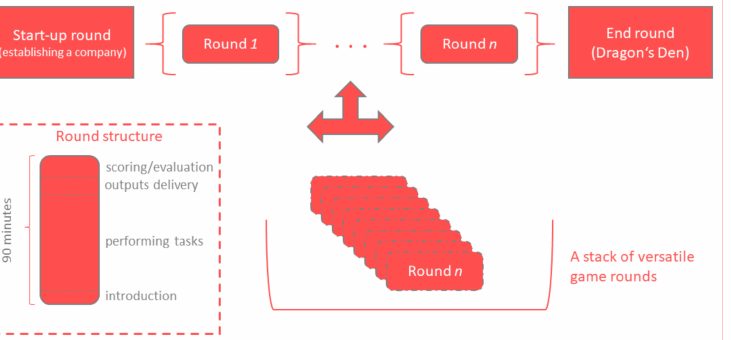
Figure 2. Spationomy simulation game conceptual framework illustrating universal and versatile usage of gaming rounds. Source: